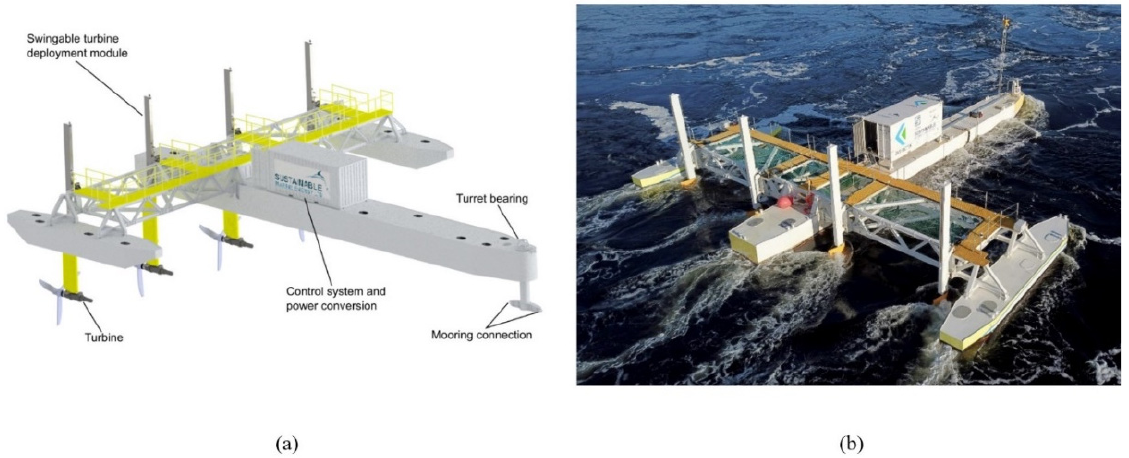
Figure 3. Example of a turbine array ( a ) CAD-model of the tidal energy converter system PLAT-I ( b ) Full-scale tests in Western Scotland, UK [56]. ( b ) Full-scale tests in Western Scotland, UK